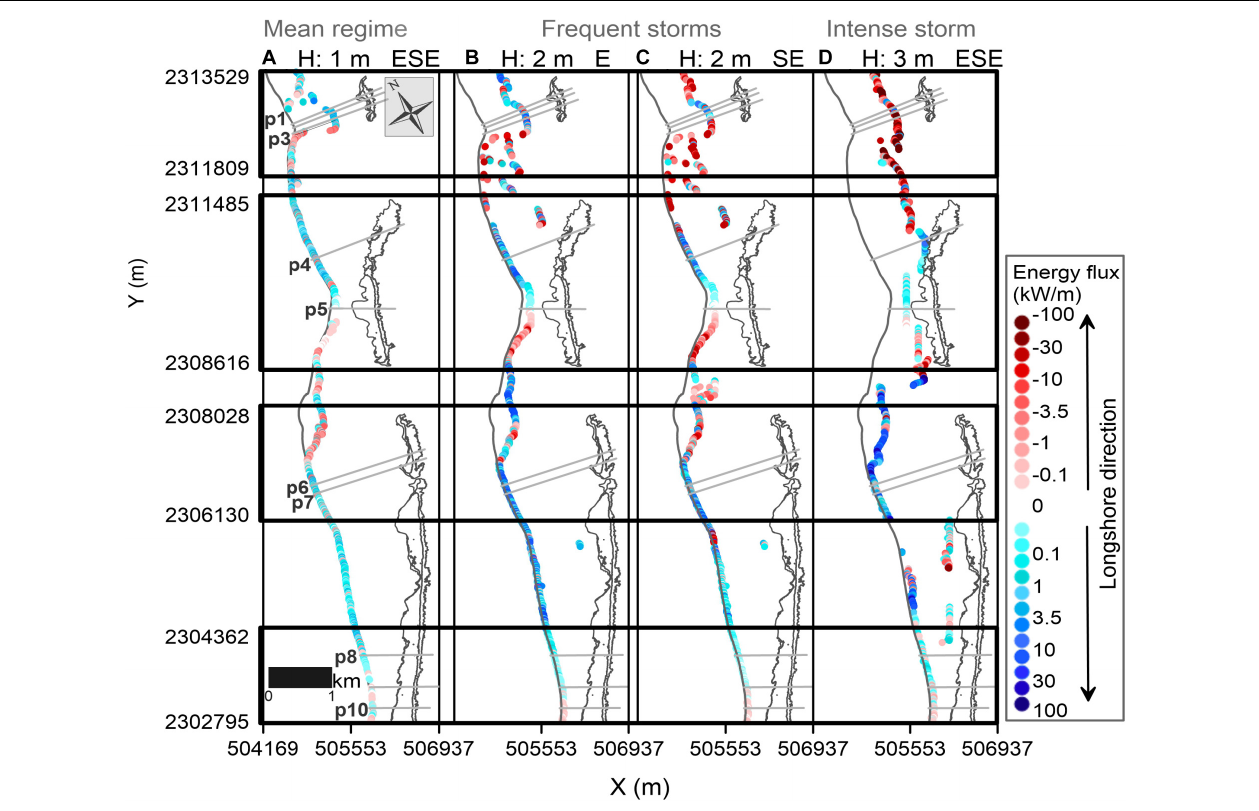
FIGURE 10 | Longshore wave-energy flux at the breaking point. High absolute values indicate more sediment transport